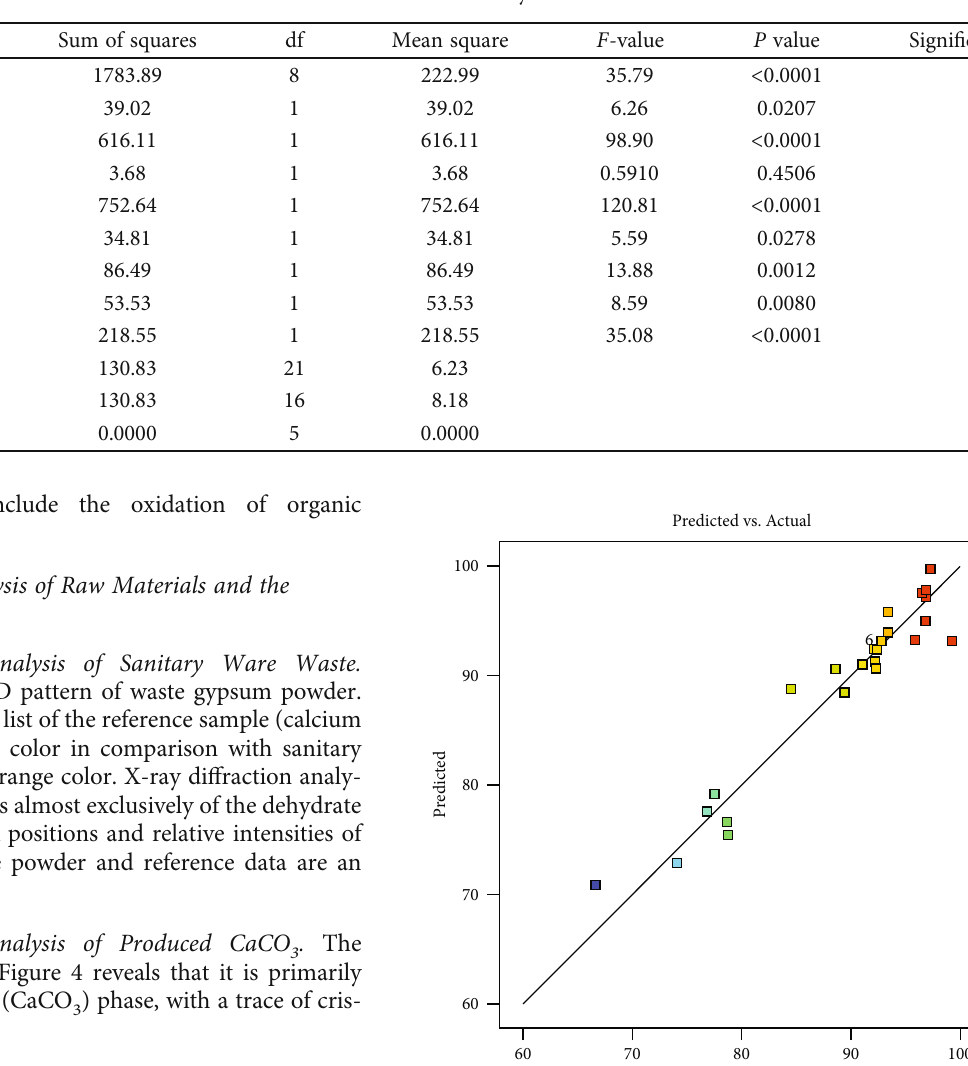
Table 5: Results of ANOVA analysis.